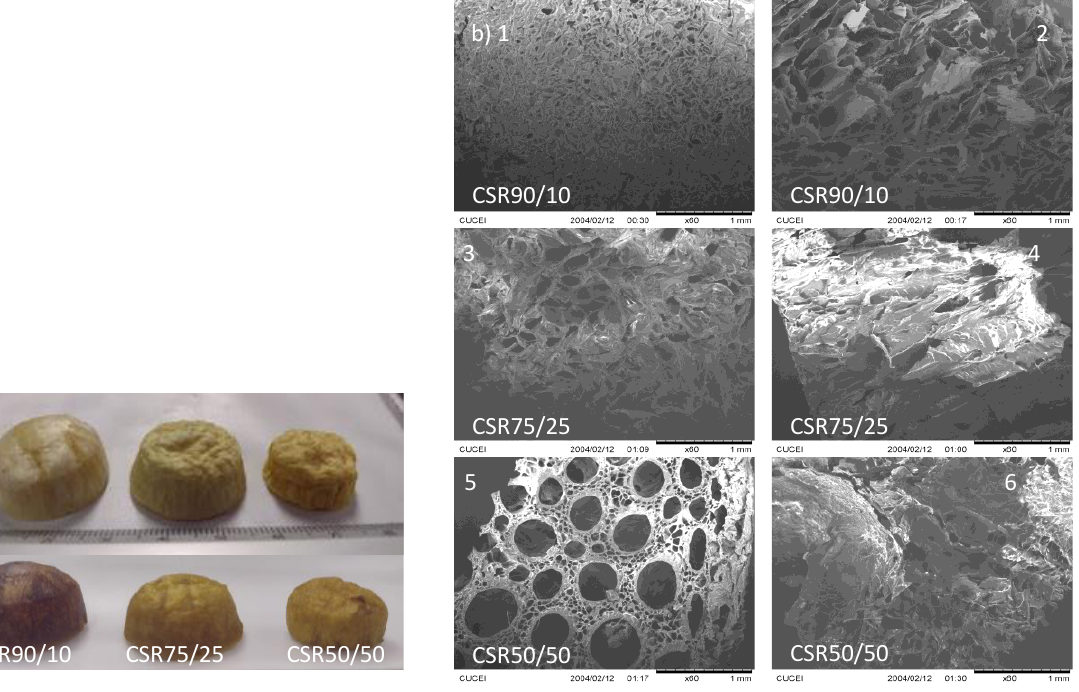
Figure 1. Chitosan/resin concentration, %vol. ( a ) CS/R aerogel before adsorption (above) and after adsorption (below); ( b ) SEM micrographs, 60X, of CS/R aerogel (1, 2) 90/10, (3, 4) 75/25, and (5, 6) 50/50.